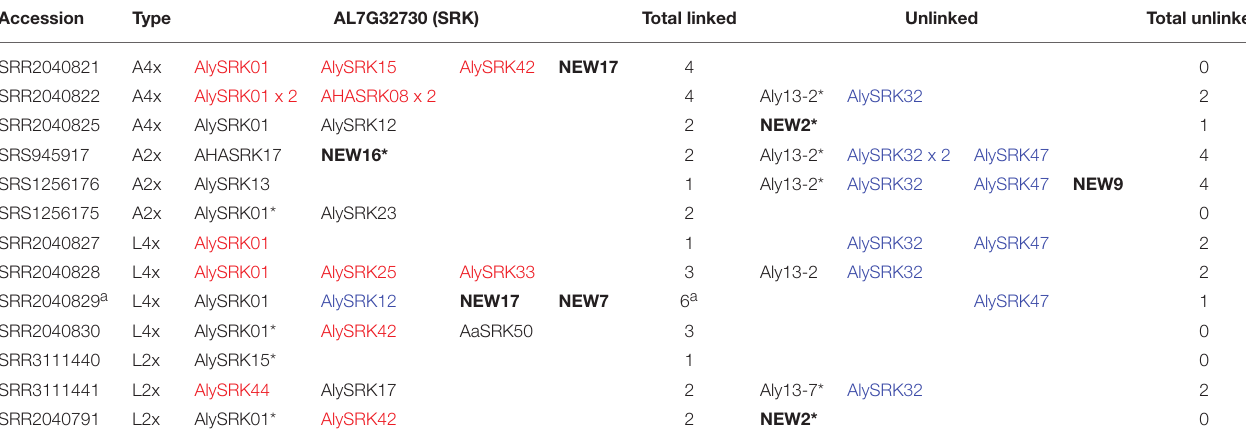
TABLE 6 | Identity of SRK -like (AL7G32730) contigs pulled out by genome mining and confirmed by phylogenetic